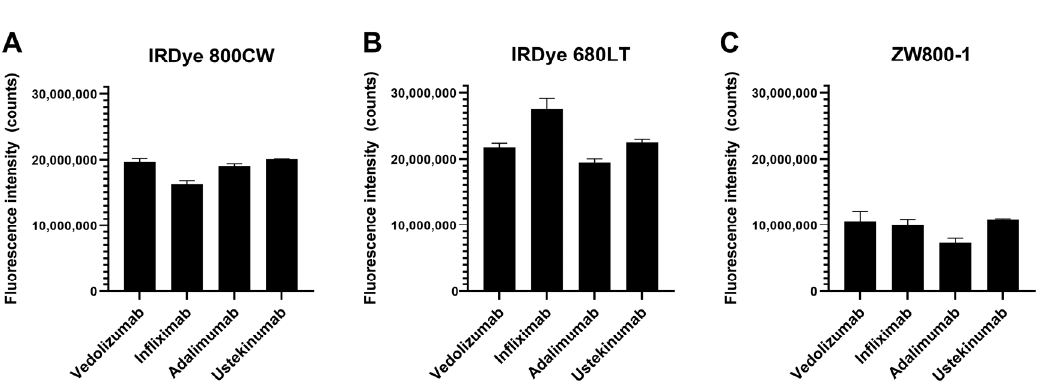
Figure 1. Fluorescent emission of the 12 tracer candidates on Odyssey CLX, grouped by ( A ) IRDye 800CW, ( B ) IRDye 680LT and ( C ) ZW800-1. All antibodies conjugated to 680LT showed fluorescence counts comparable to or higher than 800CW. ZW800 conjugates are approximately half as bright as 800CW conjugates. Higher brightness is a desirable factor for a tracer as a lower dose is required for sufficient signal. Equal aliquots of each tracer batch were measured in a single plate. Data are depicted as the mean and standard error of mean of three tracer batches for each